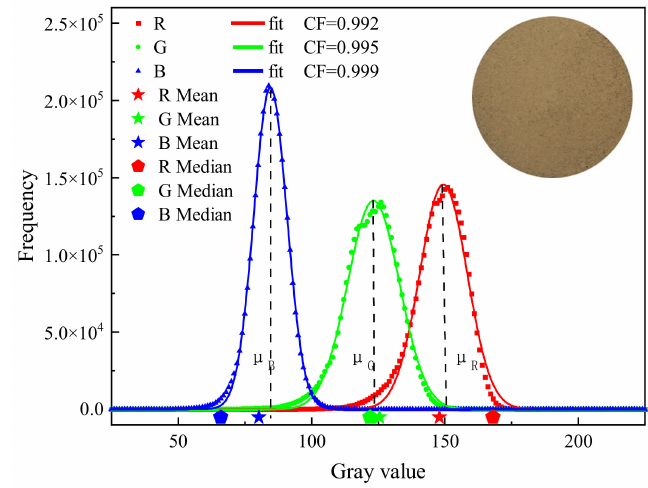
Figure 4. Gaussian fitting of RGB components.